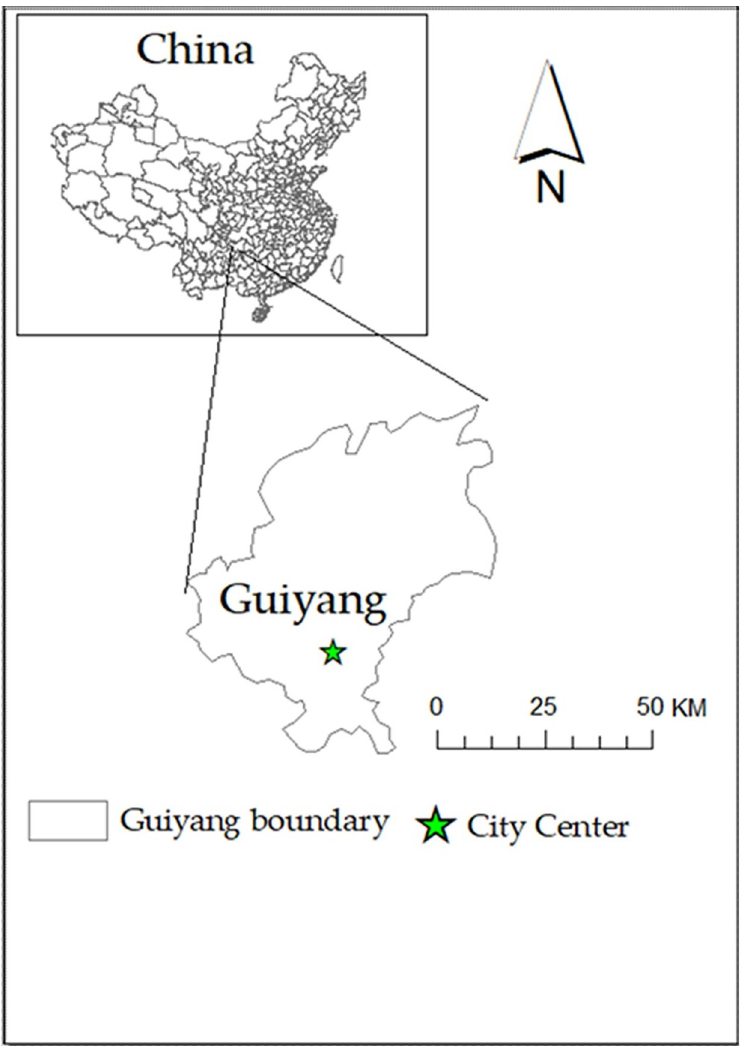
Fig 1. Location and boundary of